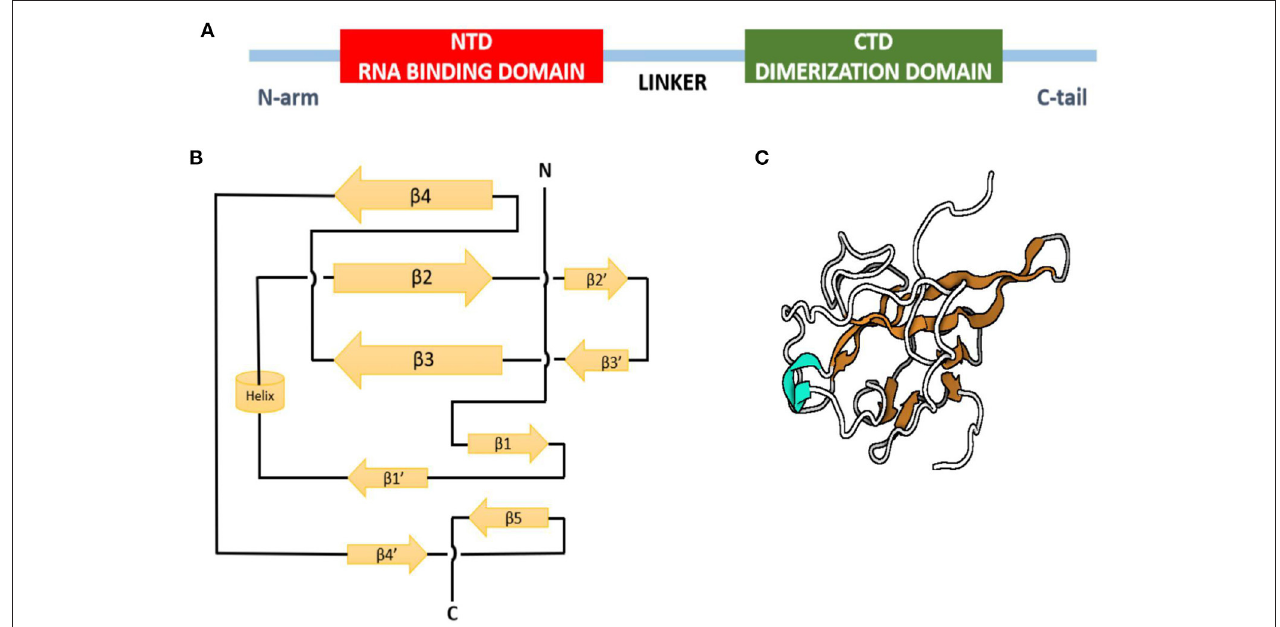
FIGURE 4 | Nucleocapsid protein of infectious bronchitis virus. (A) Domain structure of N protein. (B) Topology diagram of N protein. (C) Three-dimensional structure of N protein. Beta strands in orange, and helix is shown in cyan.